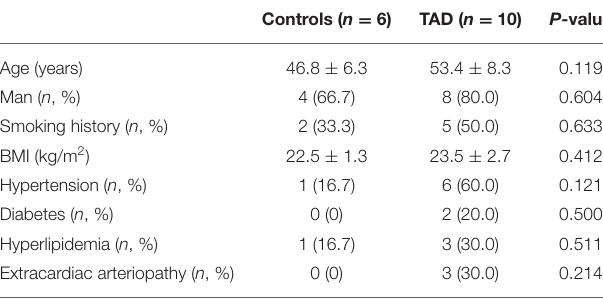
TABLE 1 | Clinical characteristics of patients provided aorta specimens.